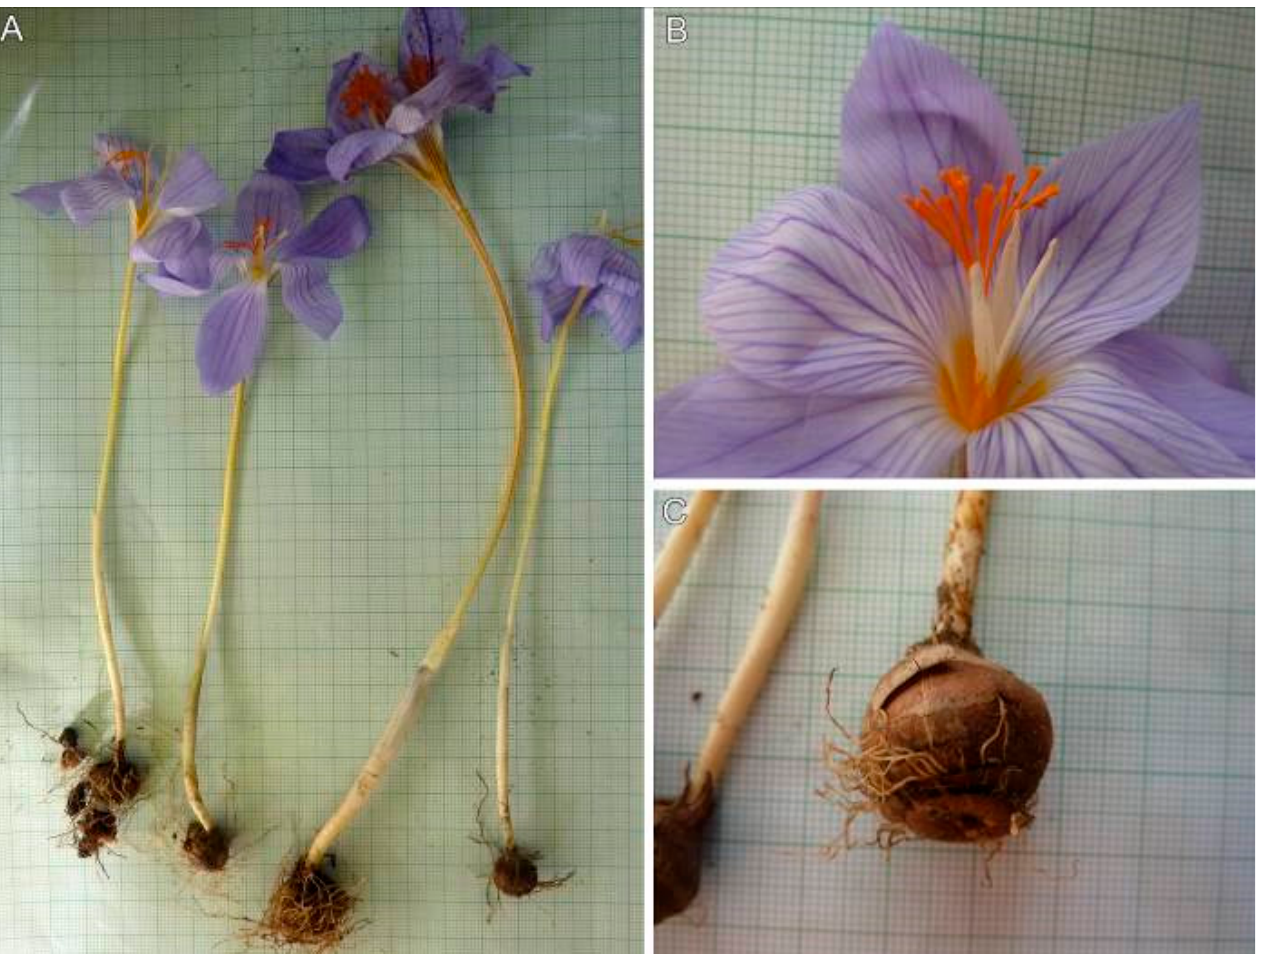
Figure 1. Morphological features of Crocus speciosus (SOA 063310, grid 1 mm): ( A ) whole plant; ( B ) anthers and stylodia; ( C ) corm.